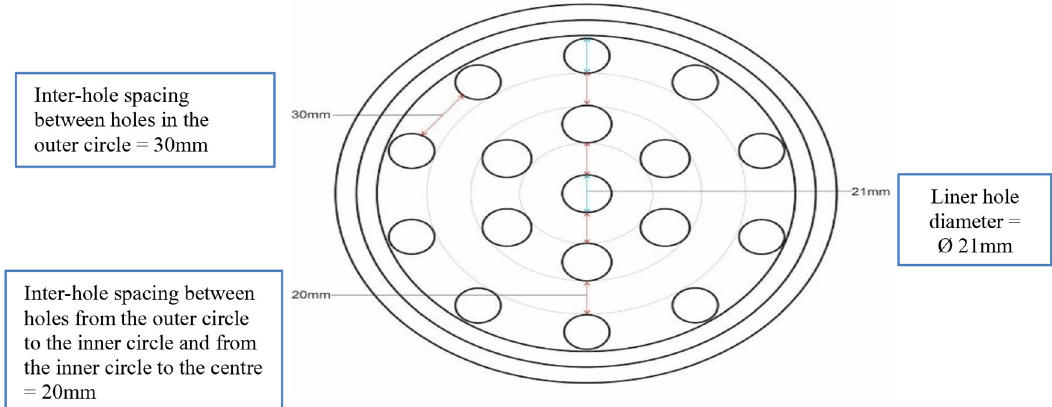
Fig. 5. Template for ceramic liner-hole diameter and inter-hole spacing.